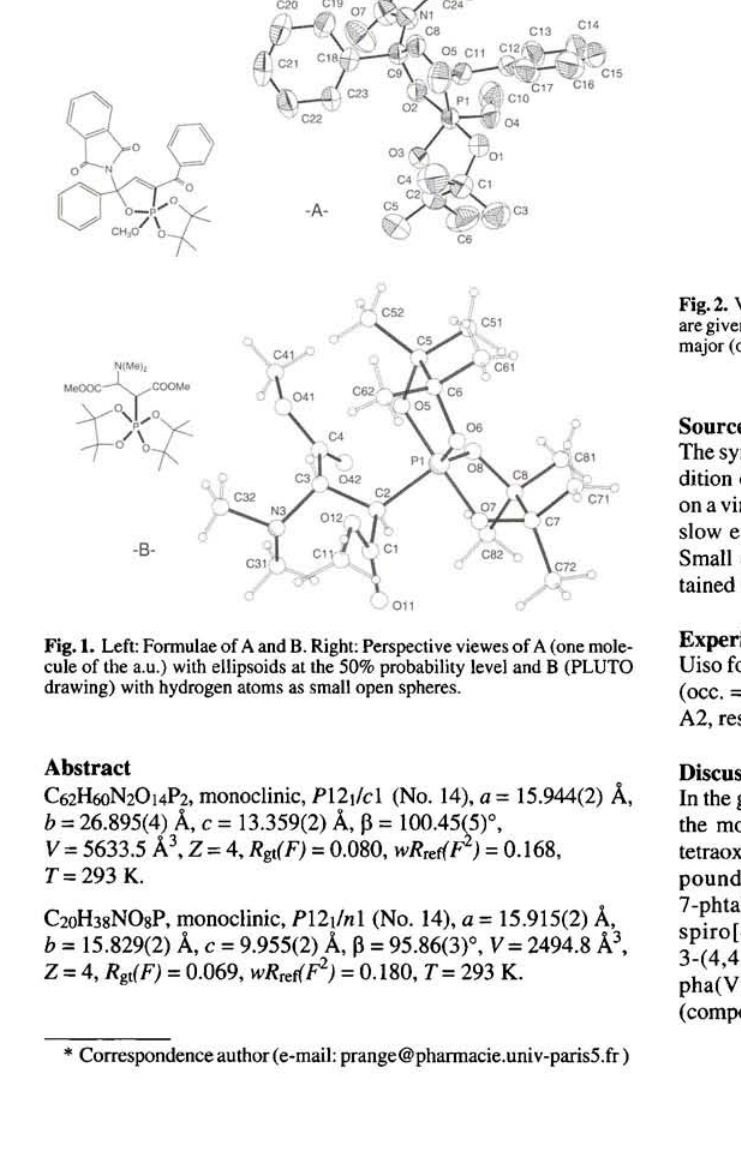
Fig. 2. View of the desordered dioxyphospholane ring in molecule A2. Atoms are given as open circles for the minor (occ. = 48.1 %) and filled circles for the major (occ. = 51.9%) conformers.